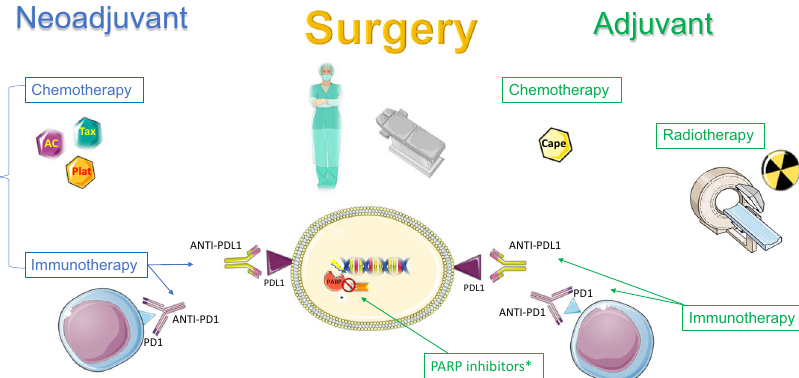
Fig. 3 Current multidisciplinary treatment of TNBC, including neoadjuvant chemotherapy plus immunotherapy, surgery and radiation, and adjuvant treatment with ongoing immunotherapy. Adjuvant PARP inhibitors are given for those with germline BRCA1 or 2 mutations and capecitabine for those with residual disease, although optimal integration in the immunotherapy era is uncertain. In blue neoadjuvant treatment; in green adjuvant treatments. *only for germline carriers of BRCA1-2 mutations. Figure includes modi fi ed templates from Servier Medical Art